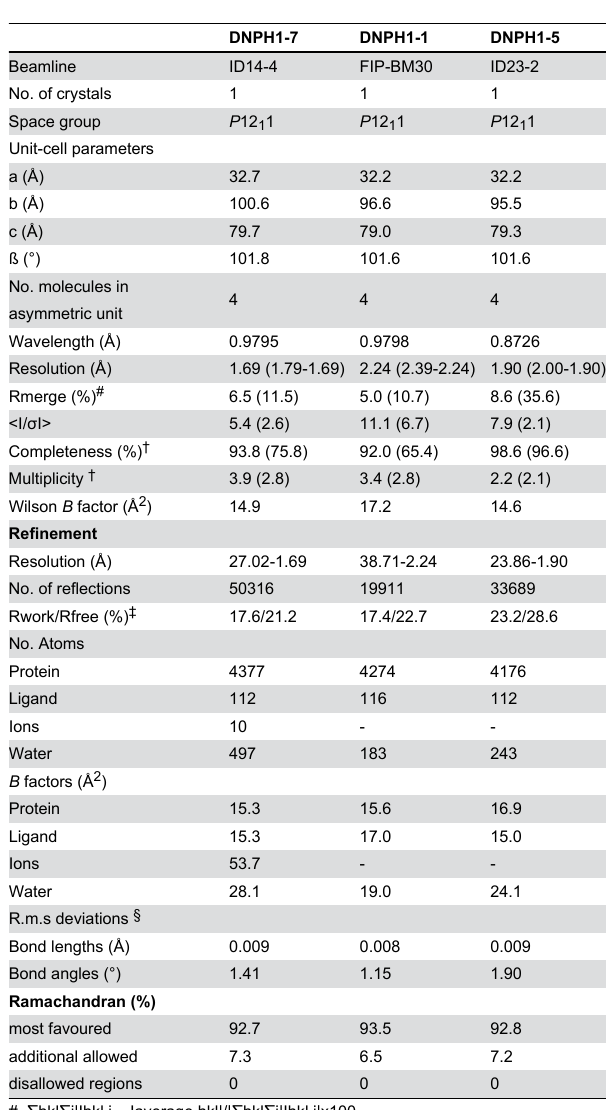
Table 1. Data collection, phasing, and refinement statistics for rat DNPH1